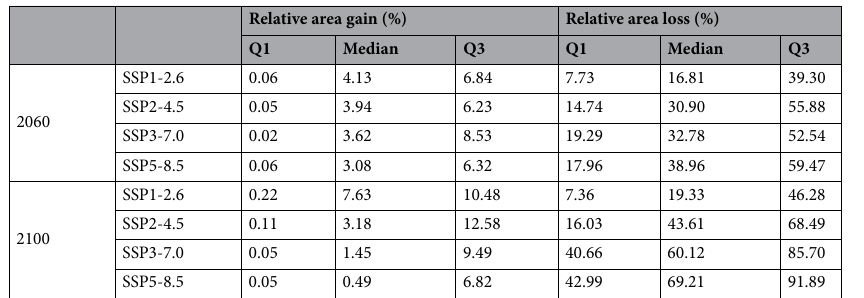
Table 2. Relative distribution area gain (%) and relative distribution area loss (%) predicted for endemic Atlantic Forest primates. Median and quartiles are presented for all Shared Socioeconomic Pathways (SSP1-2.6, the most optimistic one, SSP2-4.5, SSP3-7.0 and SSP5-8.5, the most pessimist one) for two times in the future (2060 and 2100) without considering potential dispersal.